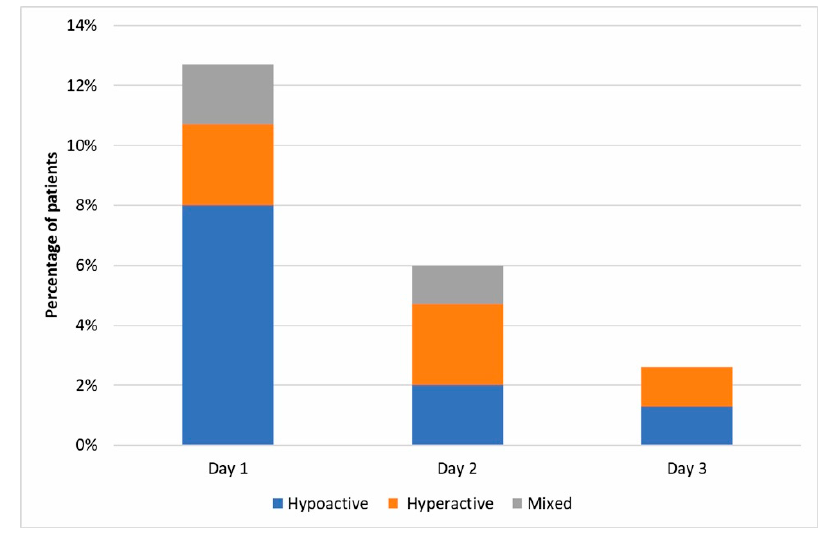
Figure 2. Postoperative delirium cases identified on days 1, 2, and 3 after surgery.